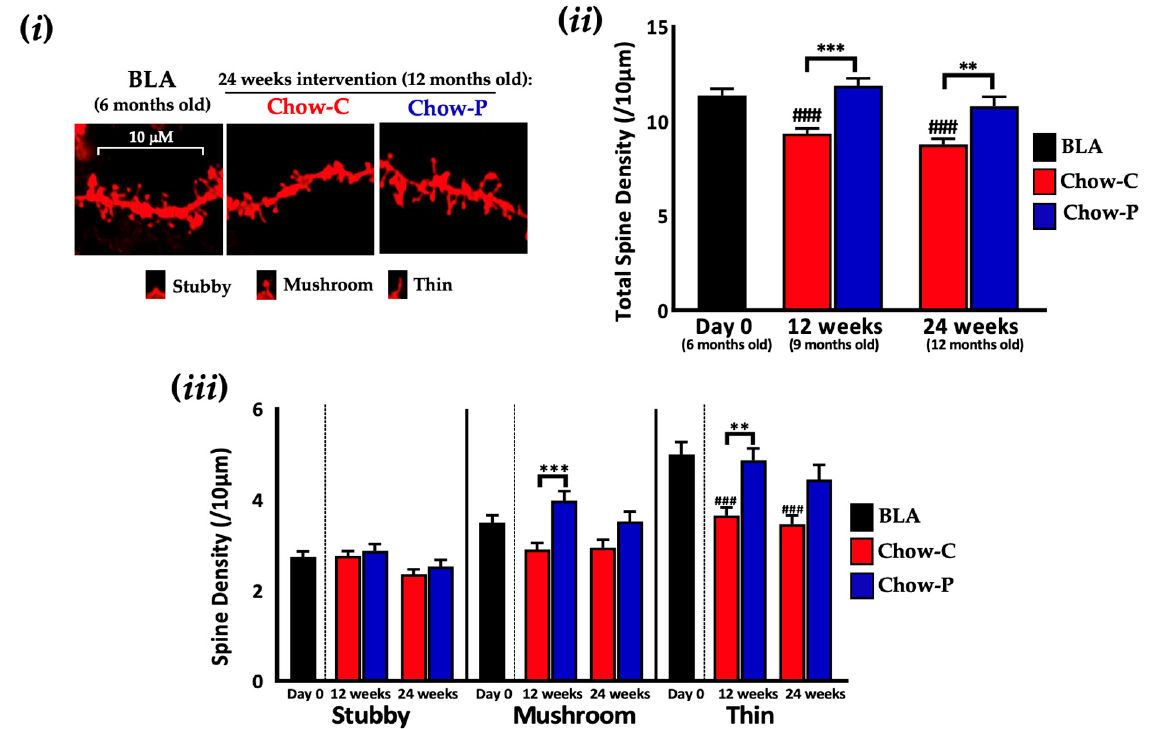
Figure 2. The impact of 24 weeks supplementation with Lab4P on neuronal spine density and mRNA expression in the hippocampus of 3xTg-AD mice (Study A). ( i ) Representative DiOlistic-labelled dendritic segments from hippocampal CA1 apical dendrites with changes from baseline (BLA) in ( ii ) total or ( iii ) stubby, mushroom and thin spine densities of 3xTg-AD mice receiving chow alone (Chow-C) or chow plus Lab4P (Chow-P) for 24 weeks. Data are expressed as mean ± standard error of the mean (SEM). Mouse numbers for each data point/group. Values of p were determined using one-way ANOVA with Tukey’s post hoc analysis or Brown–Forsythe ANOVA with Dunnett’s T3 post hoc analysis where ** p < 0.01 or *** p < 0.001 versus the control or ### p < 0.001 versus baseline. mRNA expression analysis of the hippocampi of the Chow-P mice (Table 1) indicated significantly lower levels of IL-10 transcripts (66.4%, p = 0.0005) after 24 weeks compared to Chow-C, whereas all other genes were unchanged between